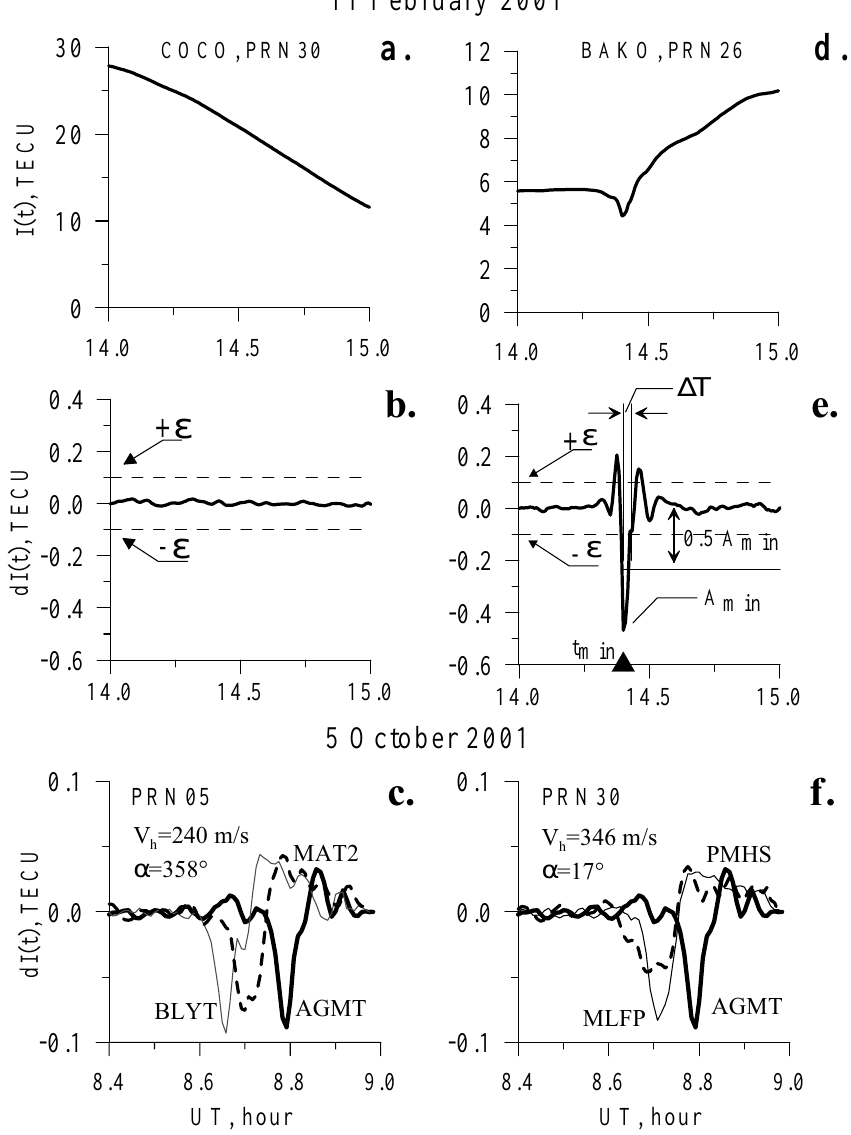
Fig. 1. An illustration of TECS selection: (a) – an example of a typical “vertical” TEC I(t) series (containing no TECS) recorded on 11 February 2001 at station COCO (96 . 8 ◦ E; 12 . 1 ◦ S); (b) – filtered dI(t) -variations (from the initial I(t) -series). Panels (d) and (e) – same but for station BAKO (106 . 8 ◦ E; 06 . 5 ◦ S), the I(t) -series containing TECS. Shown in panels (a) and (d) are the station names and GPS satellite numbers (PRN). Panel (e) shows theminimum value of the amplitude A min , the time t min corresponding to this amplitude, and the time duration 1T is shown in (e) by the shaded triangle. Panels (c) and (f) (for PRN05 and PRN30, respectively) present the filtered TECS for spaced GPS stations on 5 October